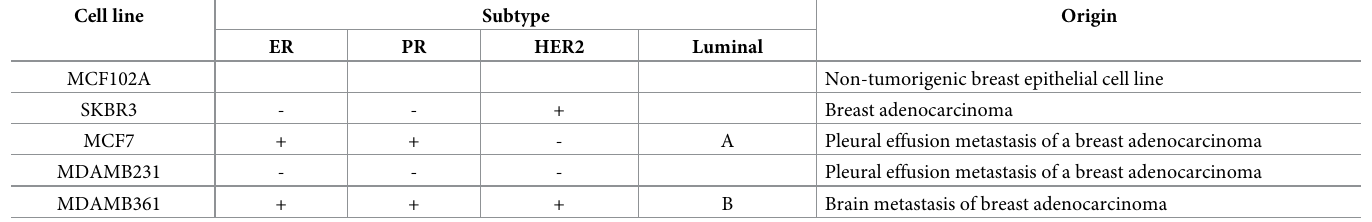
Table 1. Characterization of the investigated non-tumorigenic and cancer breast cell line in terms of their subtype and origin. ER stands for estrogen receptor, PR stands for progesterone receptor, whereas HER2 stands for human epidermal growth factor receptor-2. Cell lines may be positive (plus sign) or negative (minus sign) for each of the described subtypes. Breast cancer also includes Luminal A and B